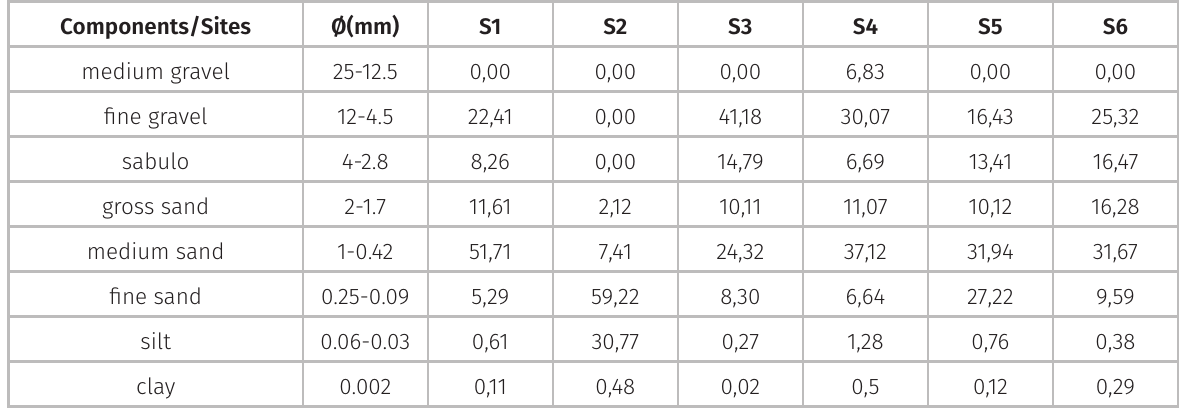
Table II. Granulometry.